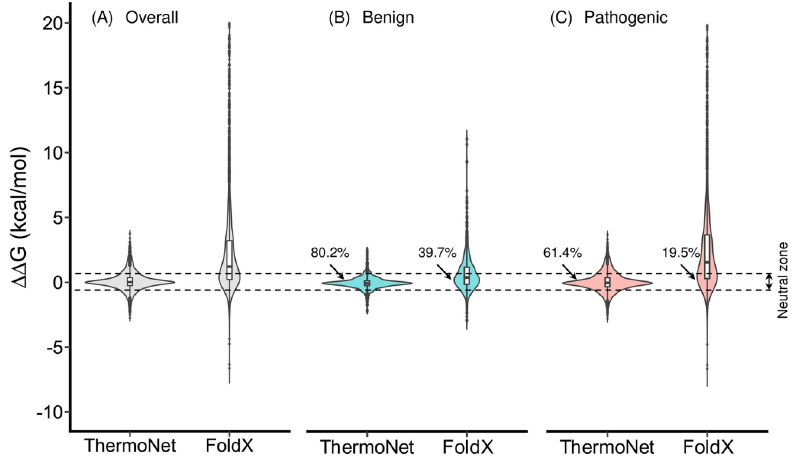
Figure 3. Comparison of the performance between ThermoNet and FoldX. This figure is reproduced with permission from reference [60], accessed on 2 February